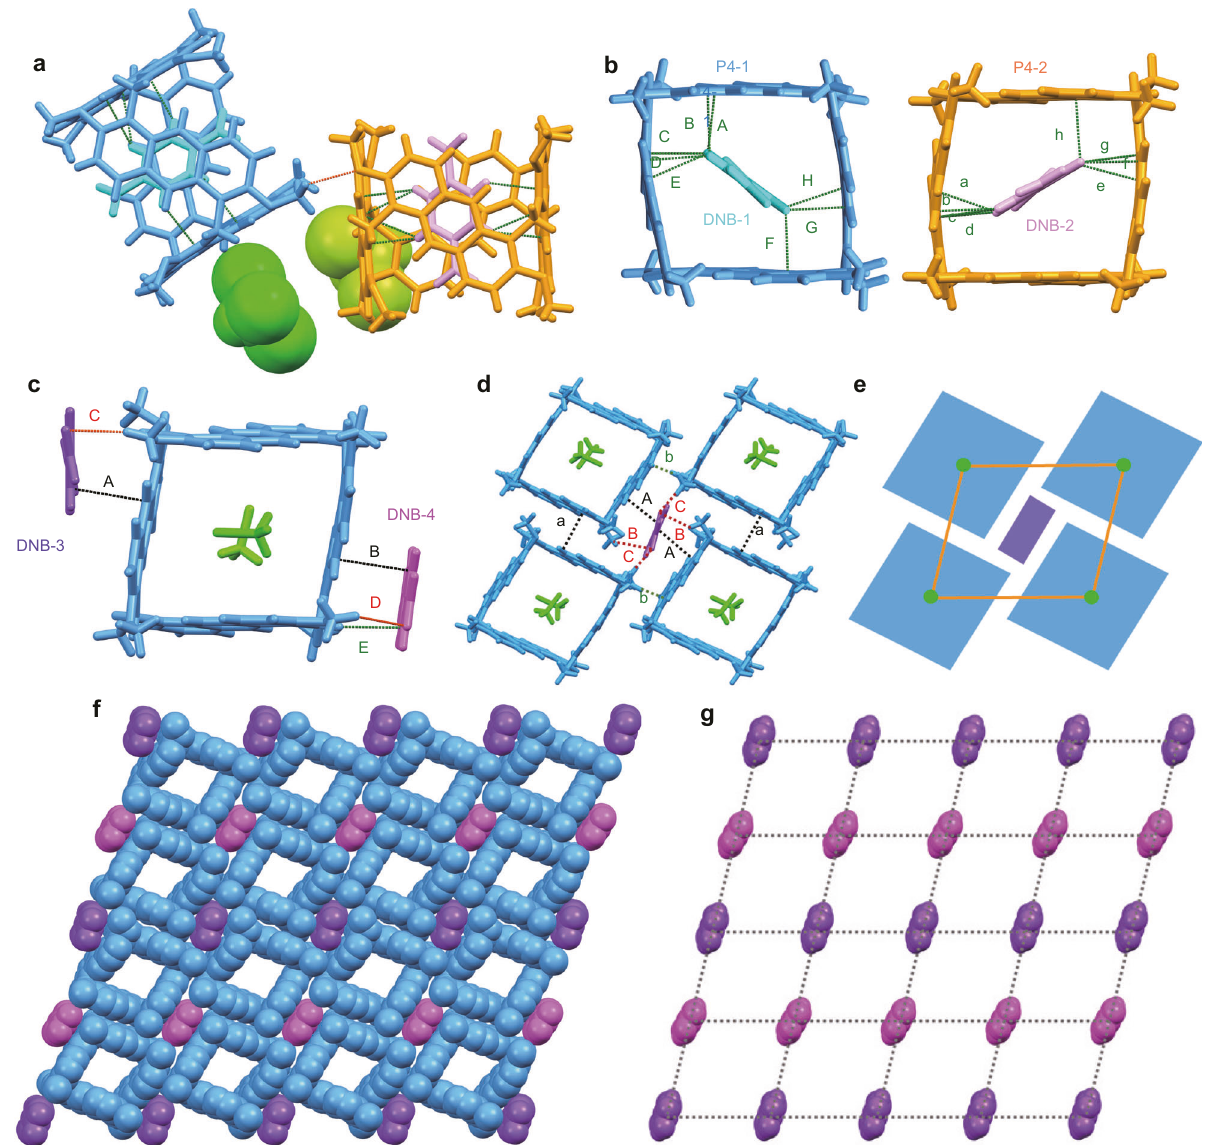
Fig. 5 Supramolecular tessellations of P4 with DNB. Crystal structure of P4-DNB a showing a side view of the asymmetric unit; b the interactions between P4 and DNB. Crystal structure of P4-DNB b showing c the asymmetric unit; d the basic tiling unit; e schematic representation of the basic tiling unit; f two- dimensional tiling of the uniform superstructure formed by P4 and DNB in a plane; g regular parallelogram grids formed by DNB molecules. Different colors represent the symmetry equivalence. Green, black, and red dotted lines represent the noncovalent interactions. Crystallographically independent P4 and DNB molecules were marked as P4-1, P4-2, DNB-1, DNB-2, DNB-3, and DNB-4,